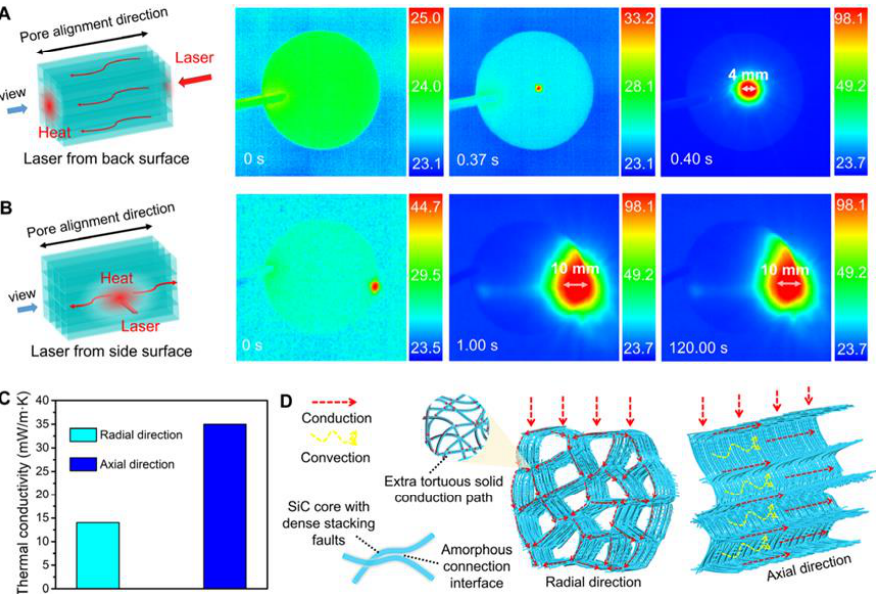
Figure 15. Thermal superinsulation performance of the AH-SSCSNWA. Thermal conducting behavior of the AH-SSCSNWA in the ( A ) axial and ( B ) radial directions, respectively, showing the anisotropic heat transfer behavior in different directions. ( C ) The thermal conductivities of the AH-SSCSNWA in axial and radial directions. ( D ) A schematic illustration showing the mechanism to achieve thermal superinsulation. (Reprinted with permission from Ref. [82]). Table 2. Physical properties of some high-temperature nanofibers aerogel.